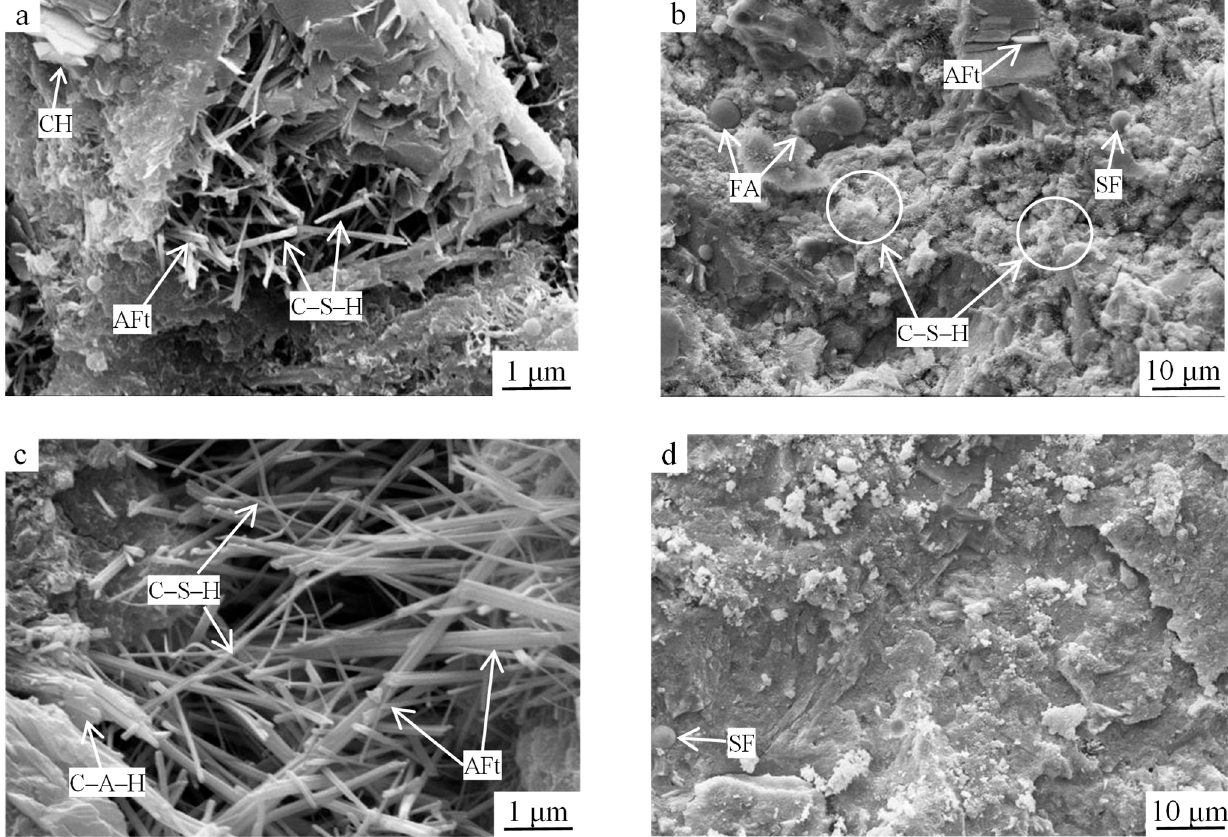
Figure 6. SEM images of the optimized group samples at ( a , b ) 3 d of age and ( c , d ) 28 d of age. SF: silica fume, FA: fly ash.